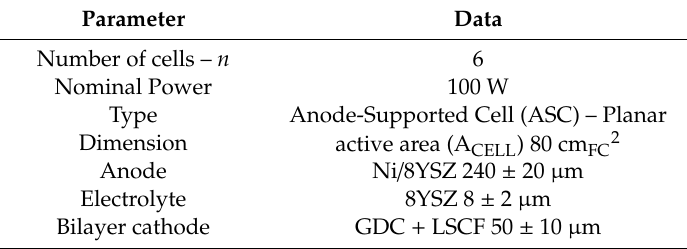
Table 2. SOFC stack design Table 2 . SOFC stack design details .